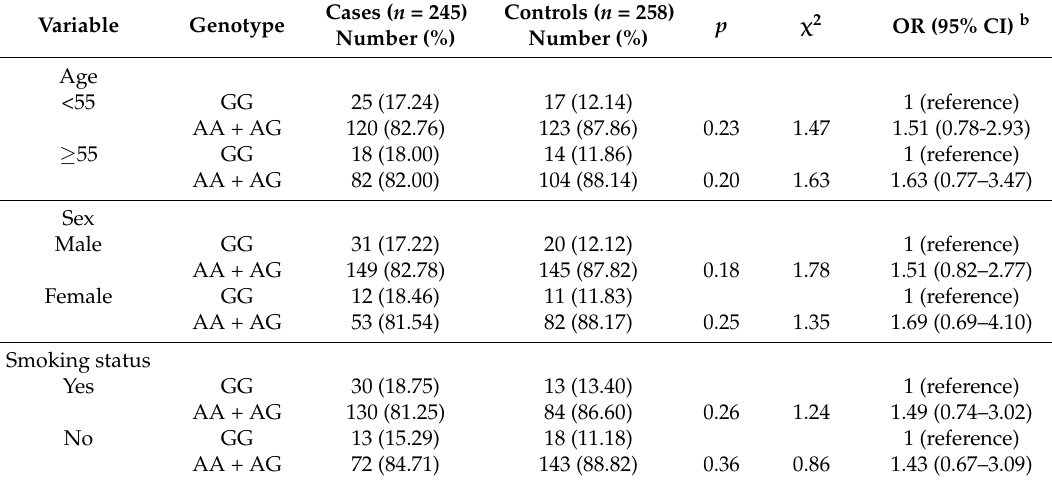
Table 3. Associations with MMP13 polymorphisms in NSCLC and control